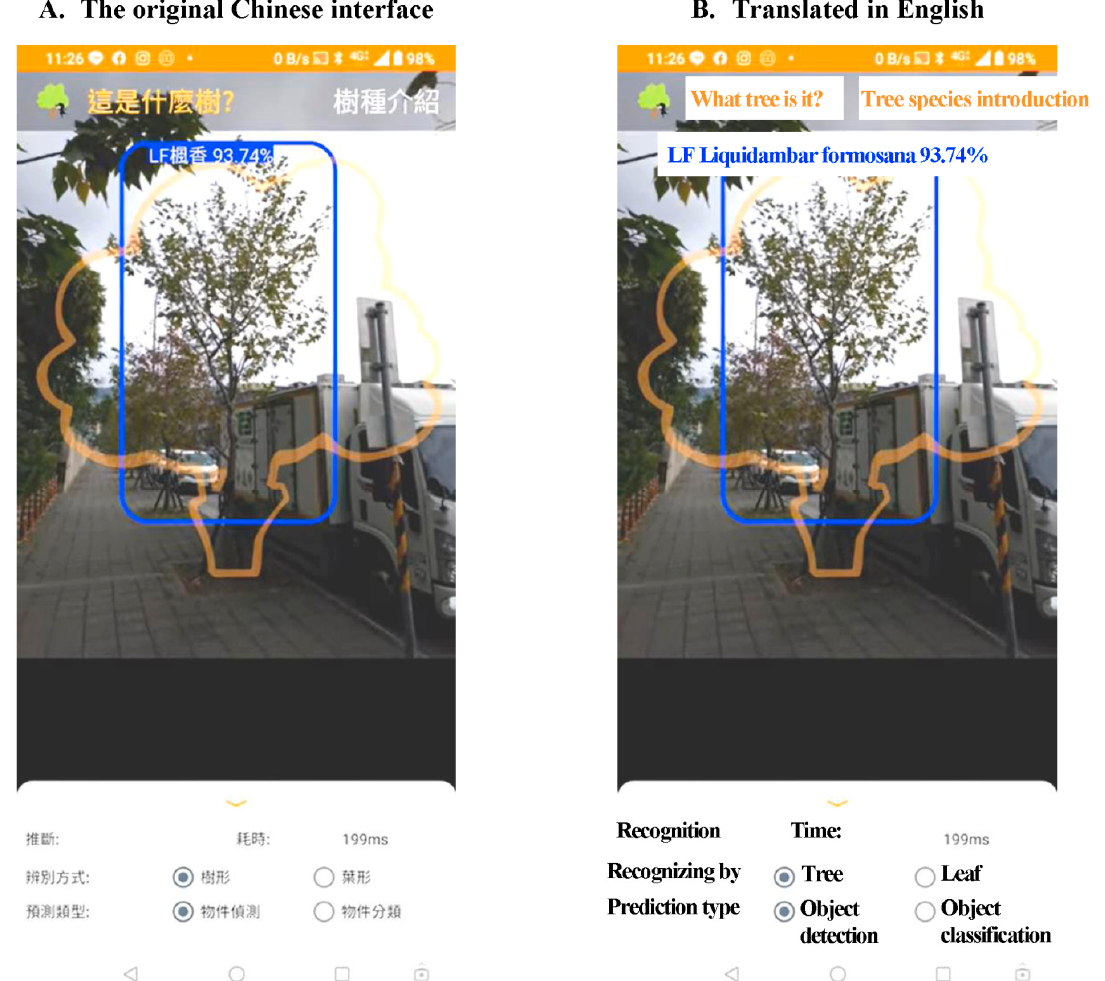
Figure 5. The screenshot of the developed mobile app. Users were instructed to place the object (tree) to be detected in the orange tree frame. In this detection, it took 199 mini seconds to frame the detected tree and show the result of Liquidambar formosana (LF). The user interface is shown in the original Chinese version ( A ), and translated in English ( B ).